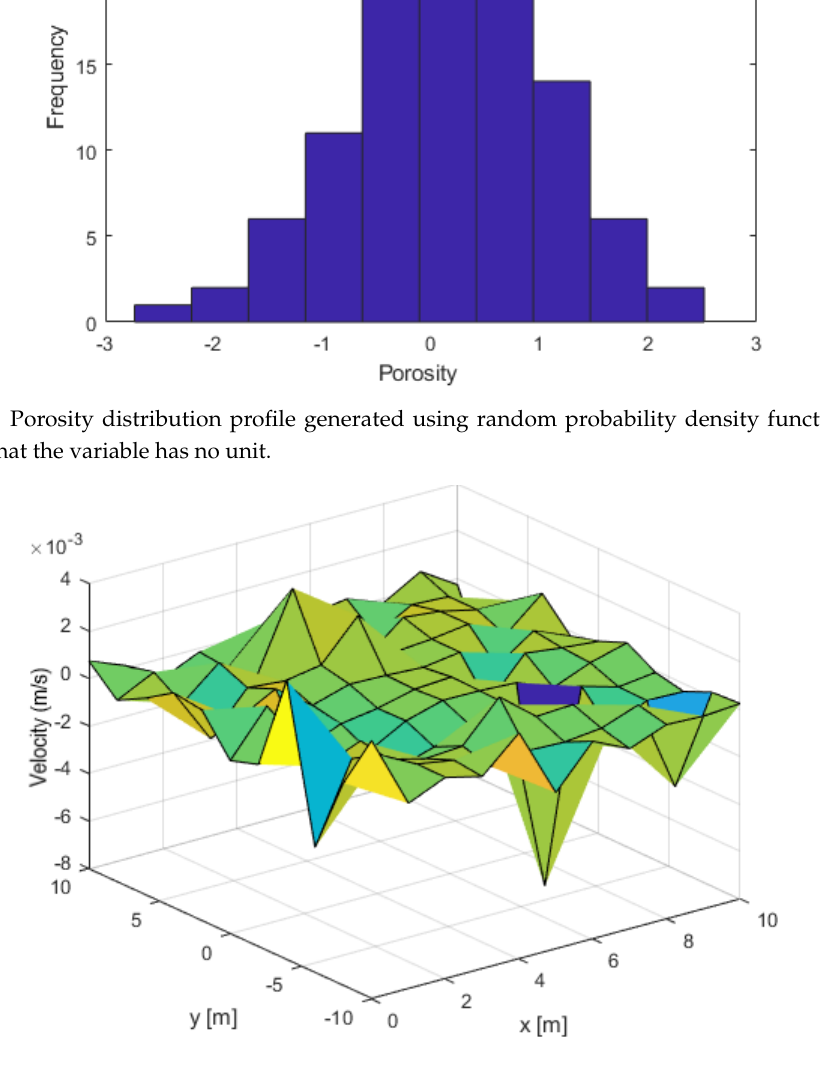
Figure 3. Typical spatial heterogeneous porous system velocity distribution (m/s) used in the numerical